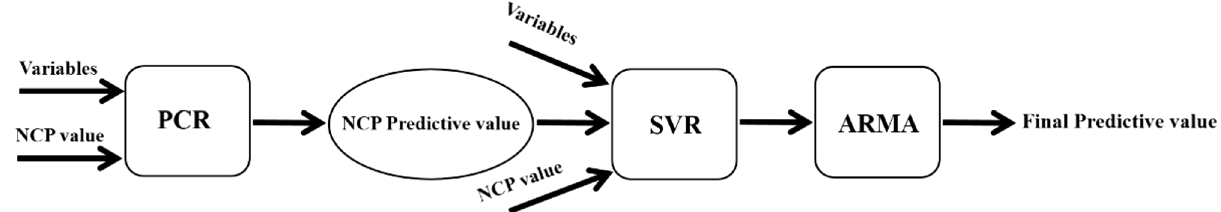
Figure 5. The flux diagram of the regression process.